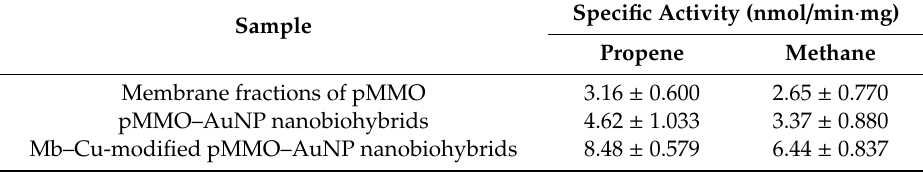
Specific activity of propene epoxidation and methane oxidation catalyzed by di ff erent particulate methane monooxygenase (pMMO) samples. AuNP—gold